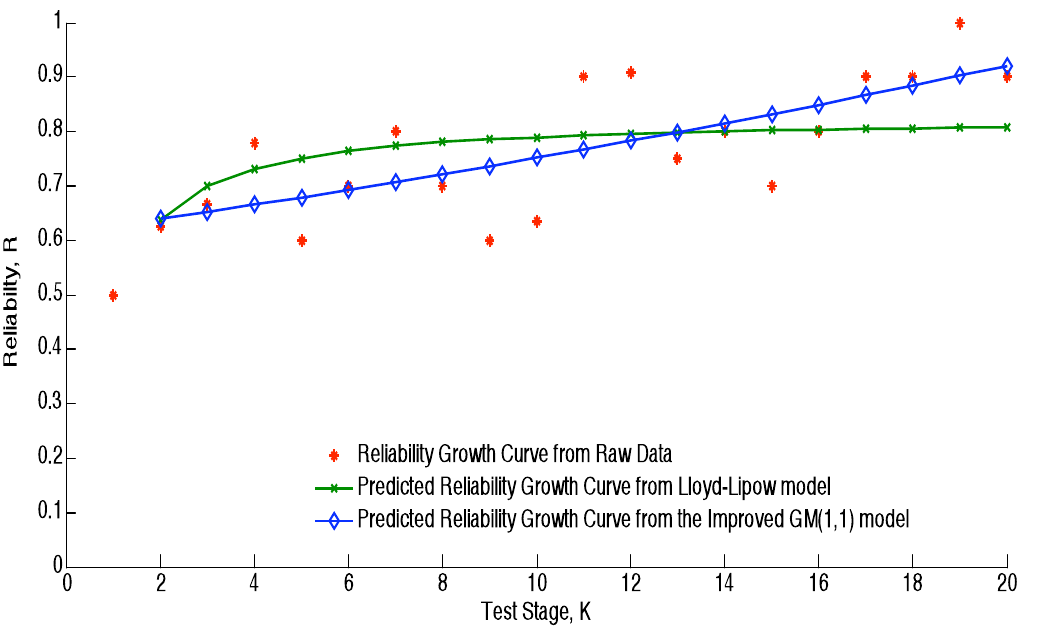
Fig. 1. Reliability growth curves predicted from the Lloyd-Lipow model and the improved GM(1,1)